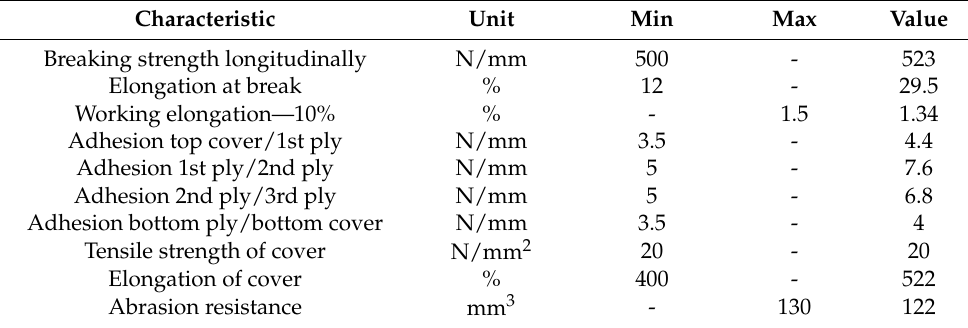
Figure 5. Model of a plain-woven EP conveyor belt carcass [40]. The belt characteristics are provided in Table 1. Table 1. Characteristics of the selected belt from the manufacturer’s datasheet.